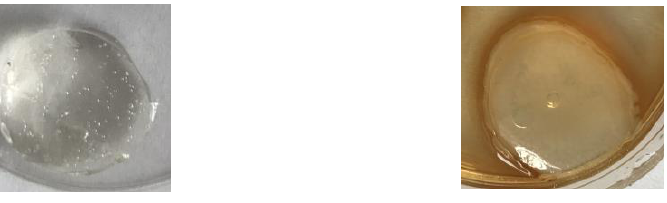
Figure 1. The shape of samples used for mechanical testing without immersion in TA ( left ) and after immersion in 20% TA solution ( right ).